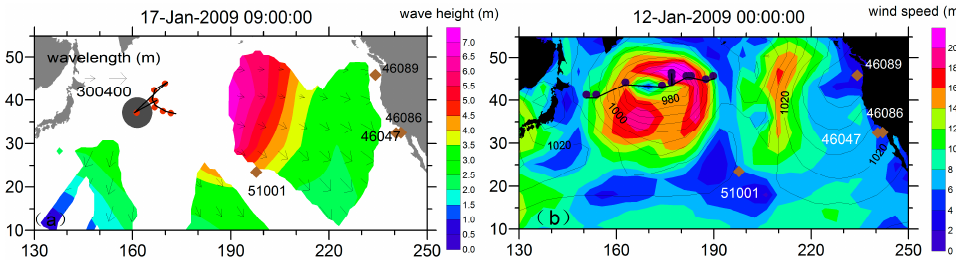
Figure 4. ( a ) Swell field of 17 January 2009, in which the contour represents the significant swell height, superimposed with arrows indicating the propagation direction, and the length indicating the wavelength. The gray disk indicates where the swell was generated. The red disks are the spatio-temporal refocused sources of the SAR observations with different wavelengths from 11-Jan-2009 00:00:00 to 13-Jan-2009 18:00:00 with an interval of 6 h. The diamonds indicate the locations of the buoys used to validate the synthetic swell field (buoy 32012 at 19.6° S 84.9° W not shown here); ( b ) ECMWF wind contour of 12 January 2009 overlaid with SLP to identify the origin of the storm case investigated here. The dark blue disks represent the storm movements detected by the local SLP minima from 11-Jan-2009 00:00:00 to 14-Jan-2009 00:00:00 with an interval of 6 h. Table 1. Swell characteristics at each buoy position according to the swell source position. Buoy